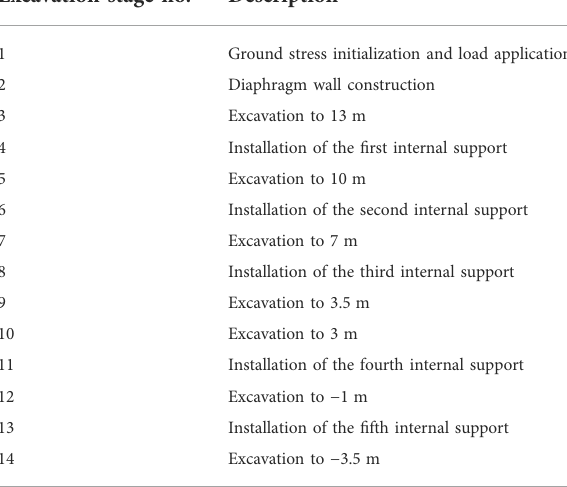
TABLE 2 Stages of excavation in FEM analysis. Excavation stage